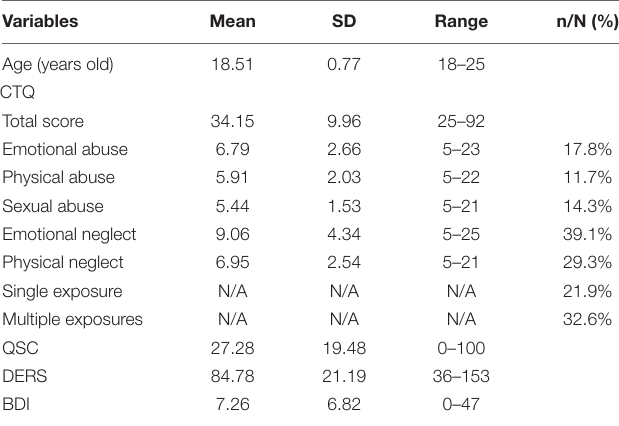
TABLE 1 | Descriptive statistics of the studied variables. TABLE 2 | Intercorrelations between the studied